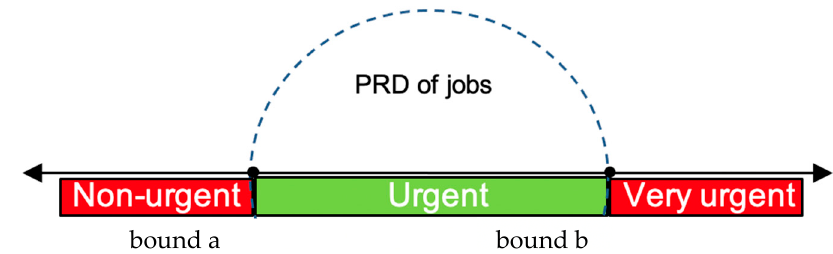
Figure 1. Classes of jobs based on urgency.